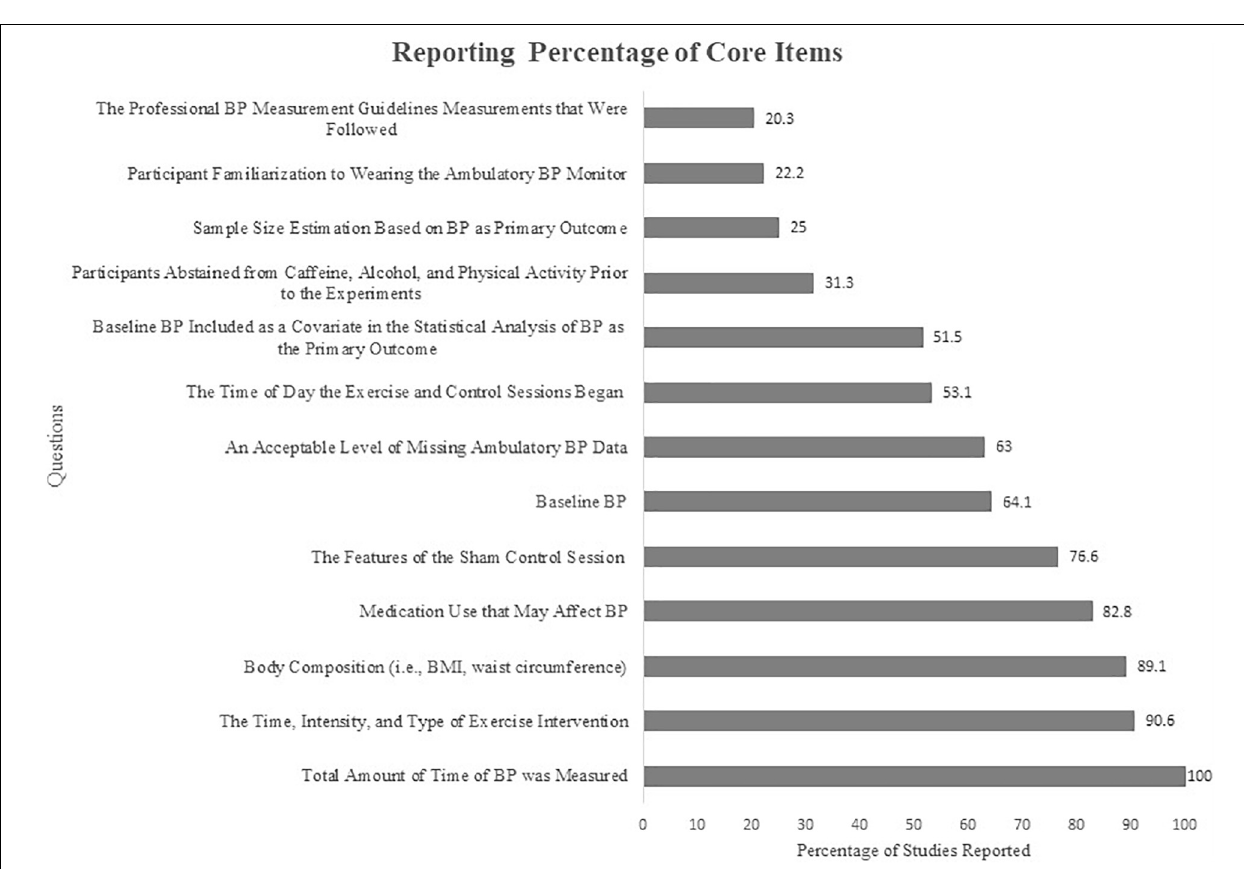
FIGURE 2 | Reporting percentage of PEH